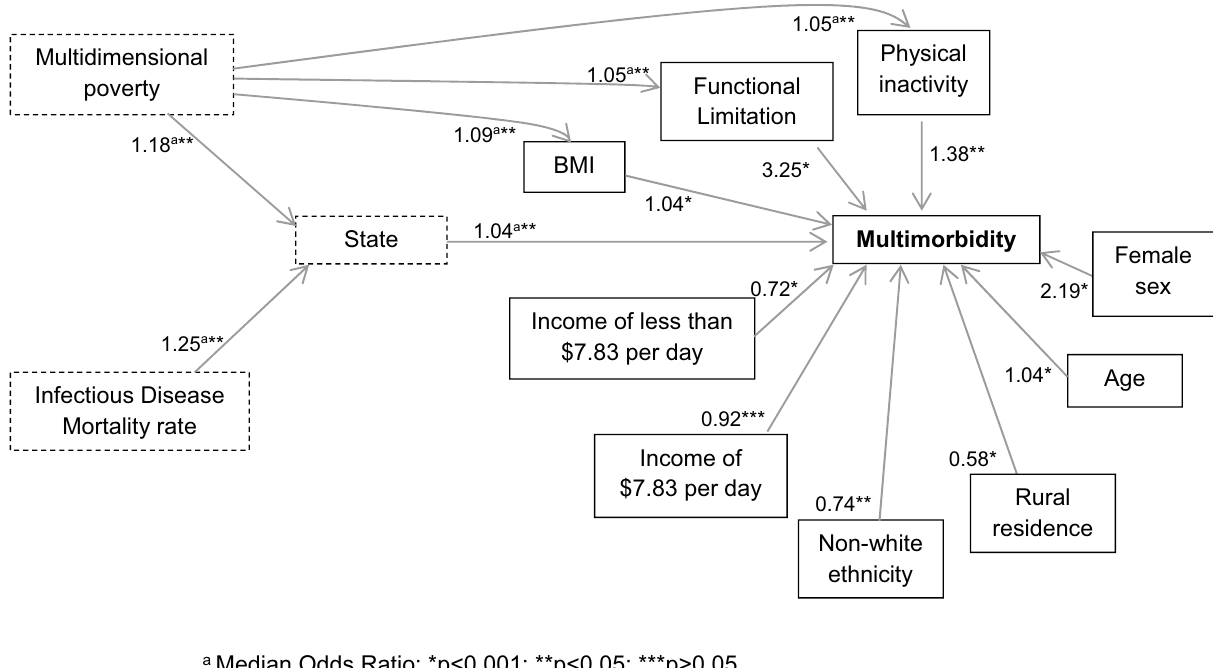
Figure 1. Final structural equation model (SEM). Odds ratio, median odds ratio and P-values. a Median odds ratio; *p < 0.001; **p < 0.05; ***p >